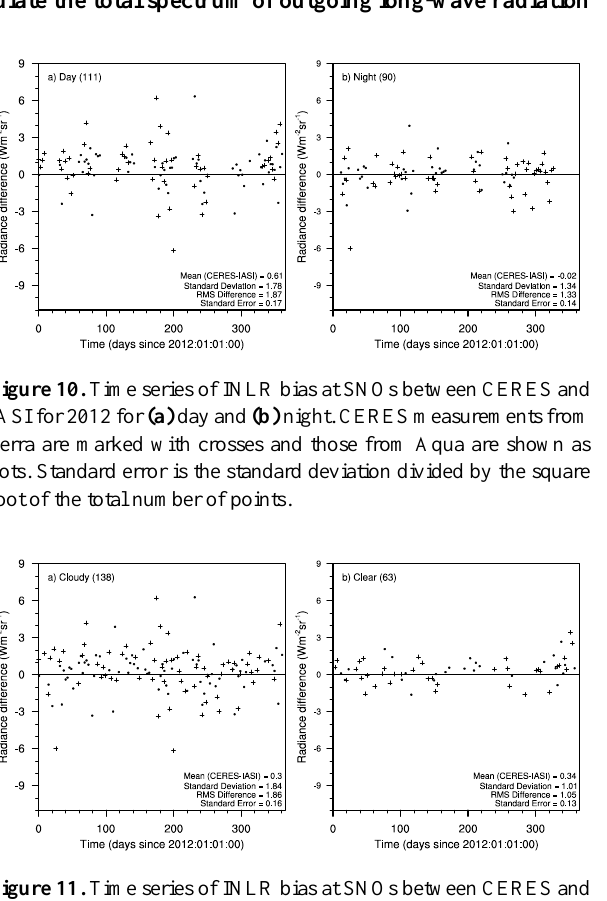
Figure 11. Time series of INLR bias at SNOs between CERES and IASI in 2012 for (a) cloudy and (b) clear pixels, as identified by the MODIS near-infrared (NIR) 3.7µm channel. CERES measure- ments from Terra are marked with crosses and those from Aqua are shown as dots. Standard error is the standard deviation divided by the square root of the total number of